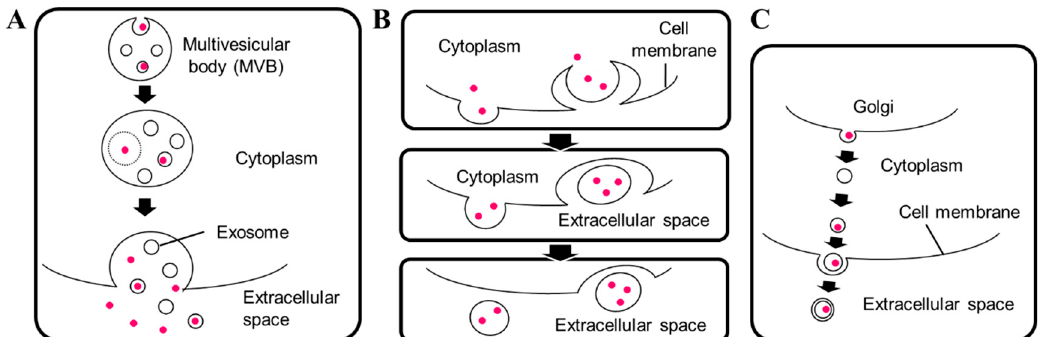
Figure 1. Different types of extracellular vesicle secretion in fungi. Prepared in reference with previous reports [25,52]. ( A ) Exosomes secreted via fusion of multivesicular body with plasma membranes; ( B ) microvesicles budding from cytoplasm; ( C ) Golgi-involved production of membrane vesicles. Pink dot: unconventionally secreted proteins.